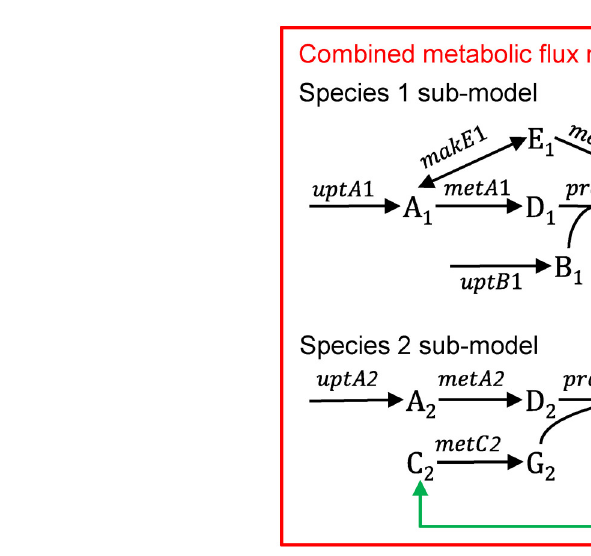
Frontiers in Microbiology |